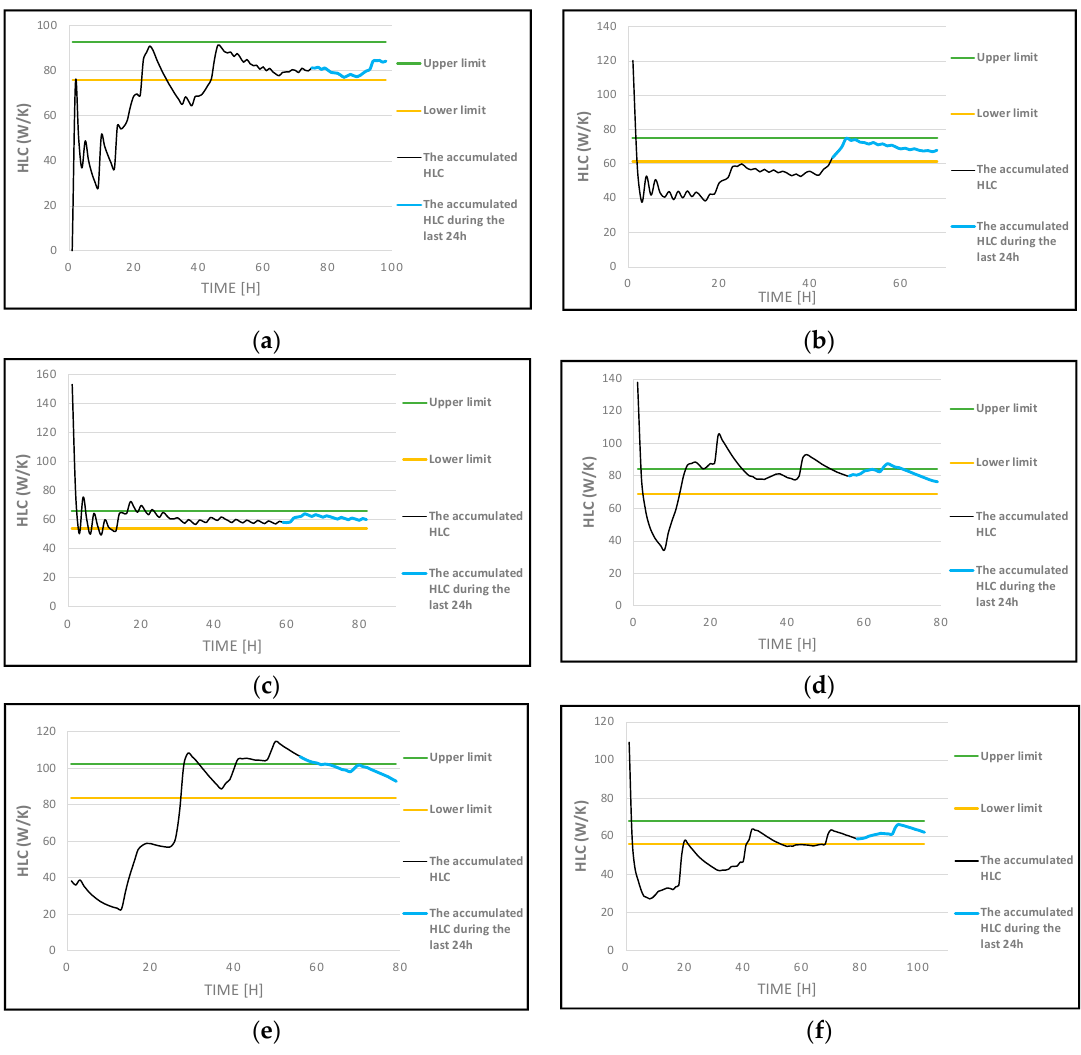
Figure A1. Evolution of the accumulated average of the Heat Loss Coefficient for ( a ) period 1, ( b ) period 2, ( c ) period 3, ( d ) period 4, ( e ) period 5 and ( f ) period 6 in Gainsborough.